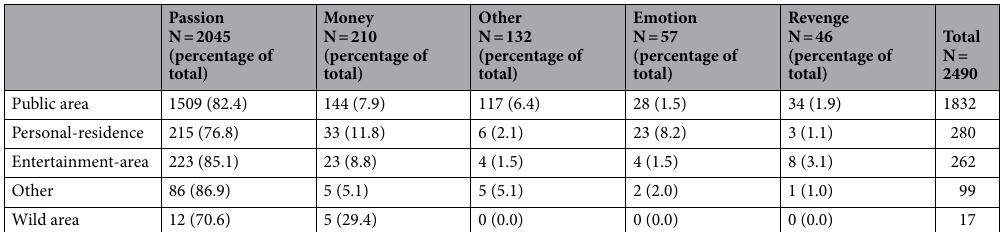
Table 3. Places in which injuries occurred stratified by motives for inflicting